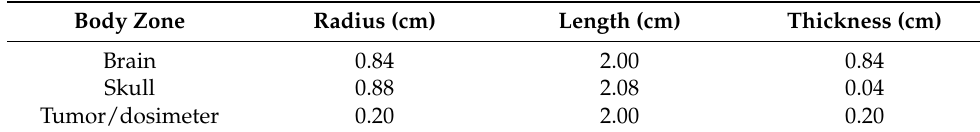
Table 2. Dimensions of the bodies in the geometry setup for the simulations.